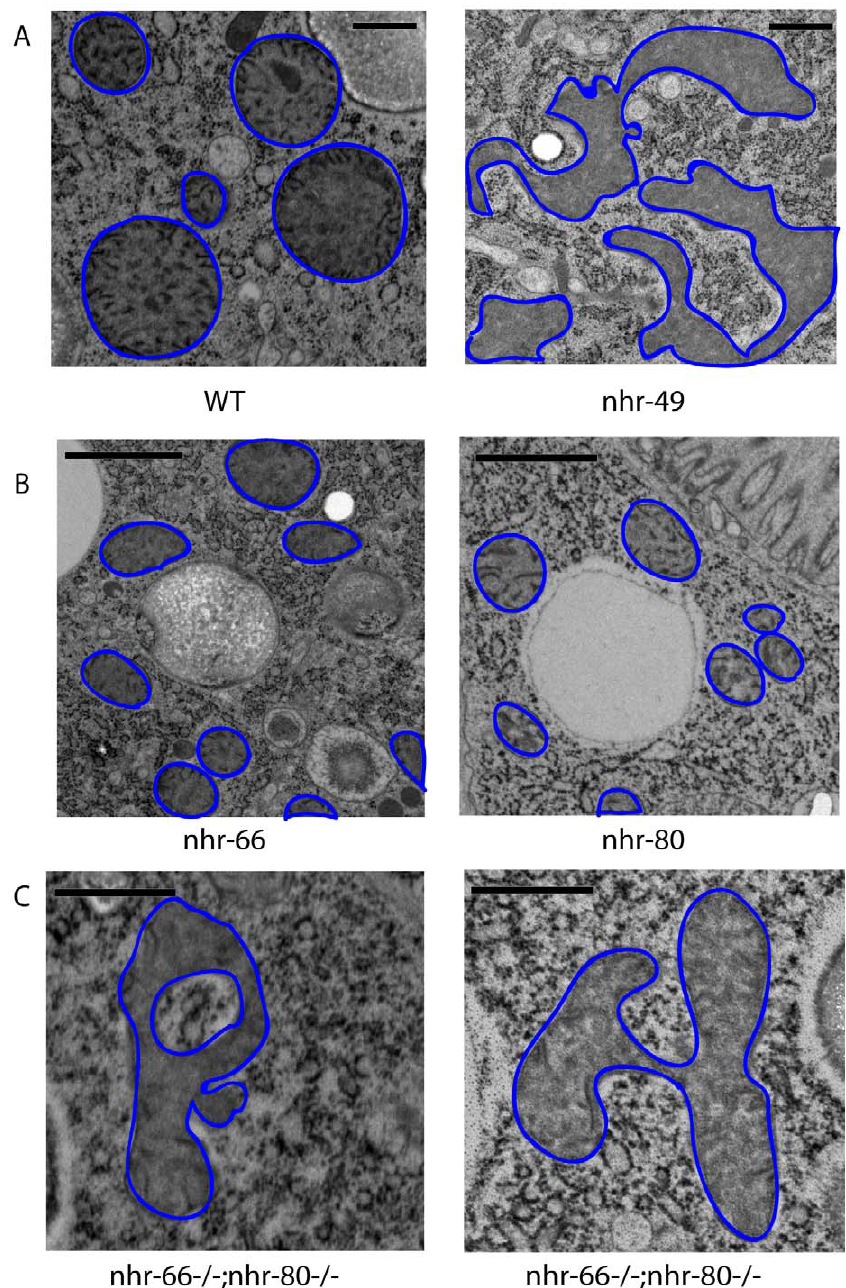
Figure 6. nhr-49 mutants show abnormal mitochondrial morphology. (A) High pressure freezing transmission electron microscopy (HP-TEM) images of wild-type animals and nhr-49 mutants at the same magnification. Note that mitochondria are outlined in blue. Bar, 0.5 m m. (B) HP-TEM images of nhr-66 and nhr-80 mutants at the same magnification. Note that the mitochondria are outlined in blue. Bar, 1.0 m m. (C) Two HP-TEM images of nhr-66; nhr-80 animals at the same magnification. Note that the mitochondria are outlined in blue. Bar, 1.0 m